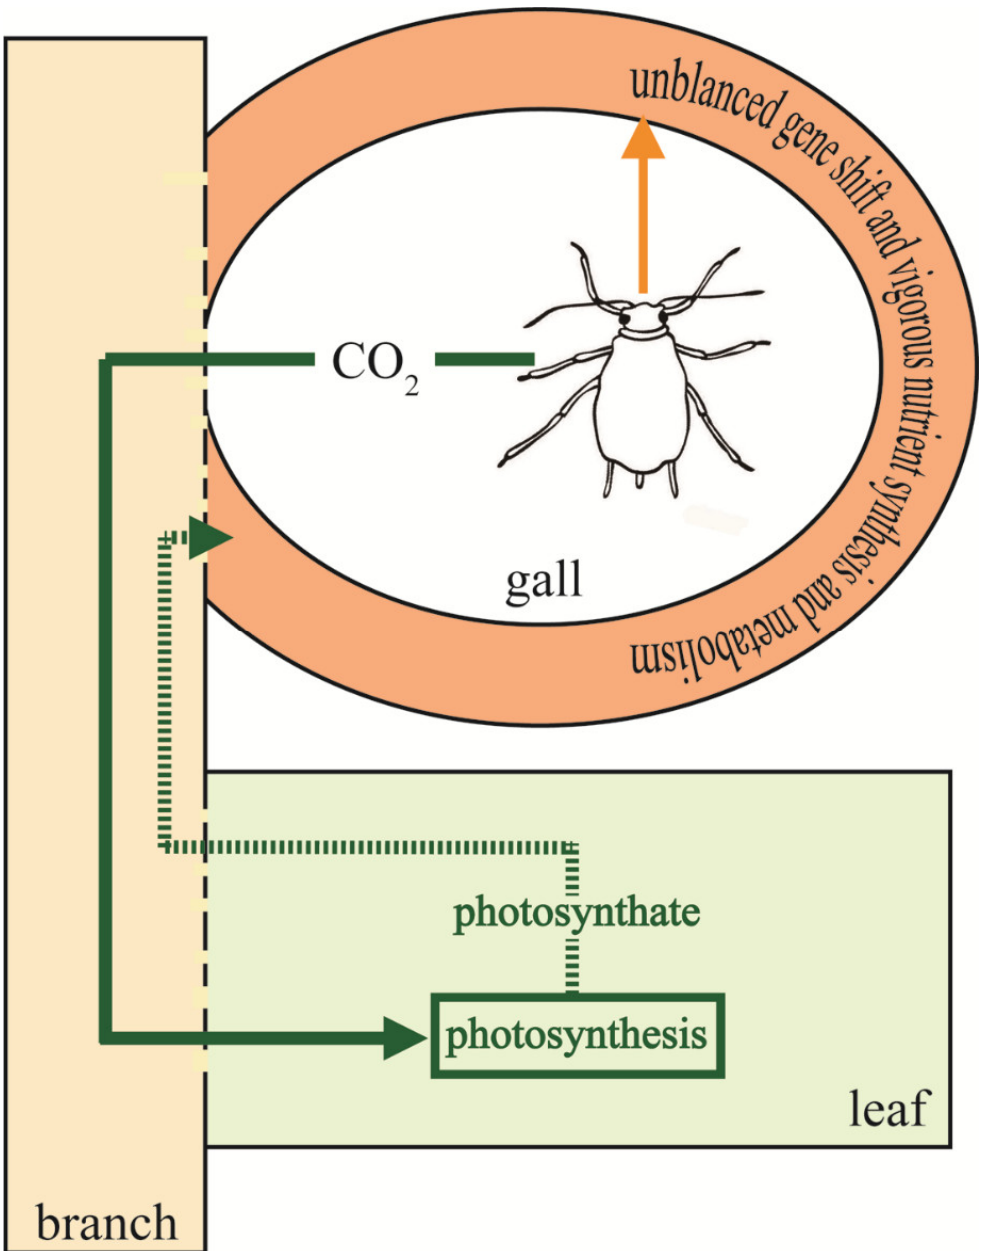
Figure 6. A model for mutualism between aphids and R. chinensis . Host plants provide aphids with photoassimilates, minerals, and other nutrients. The aphids can control the horned gall and the host plant for the aphids’ own benefit, but the horned gall eases the direct conflict by unbalanced gene shifting and vigorous nutrient biosynthesis and metabolism. Aphids generate a high concentration of carbon dioxide, which can elevate photosynthesis of nearby leaf blades. In addition, aphids may also perform nitrogen fixation and other benefits for host plants. Due to the mutualism, leaves with multiple galls usually outgrow leaves without galls despite aphid feeding.